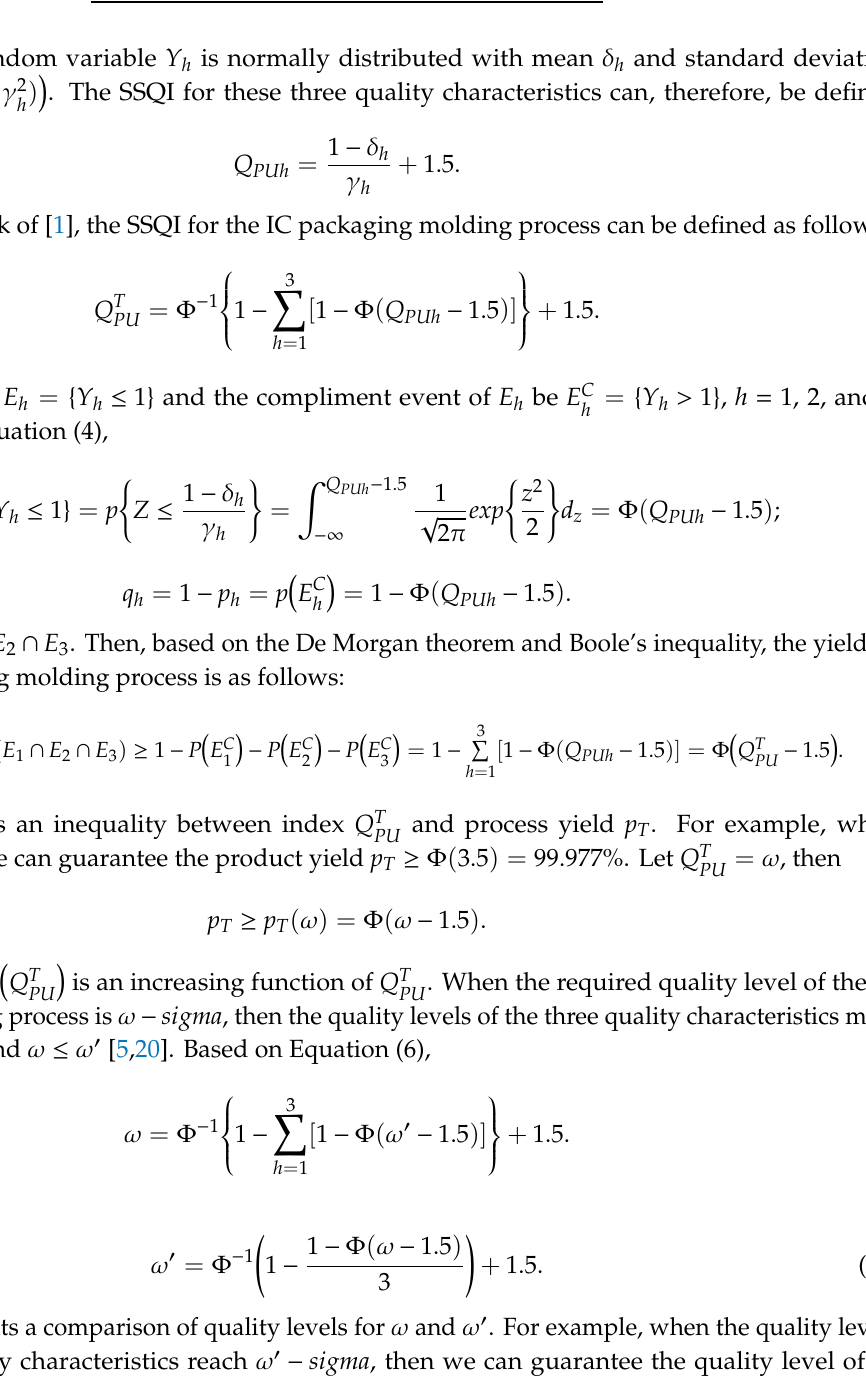
Table 1. Upper specification limit ( USL h ) of three quality characteristics. h Quality Characteristic Specification 1 Lead frame deformation < 0.05 mm 2 Wire sweep < 10% 3 Package warpage < 3